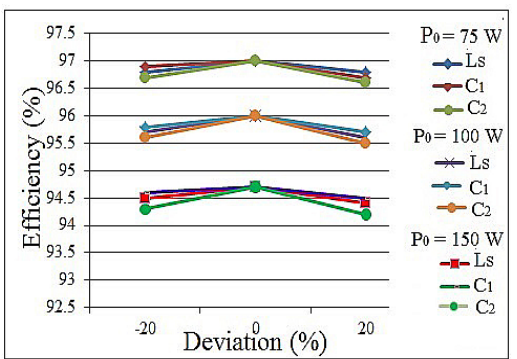
Figure 8. Deviation and efficiency.